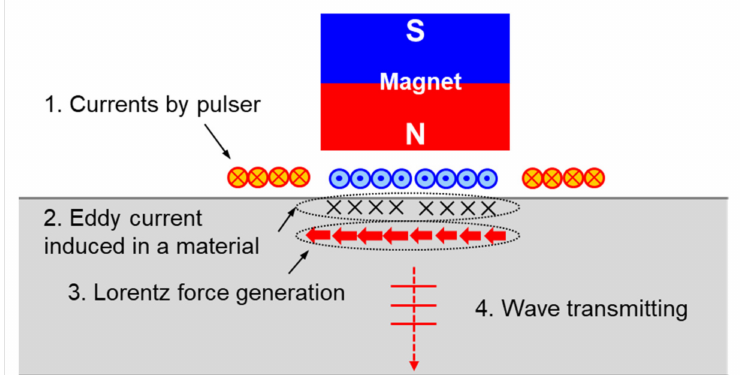
Figure 5. Ultrasonic wave generation mechanism of the EMAT used in the experiments.